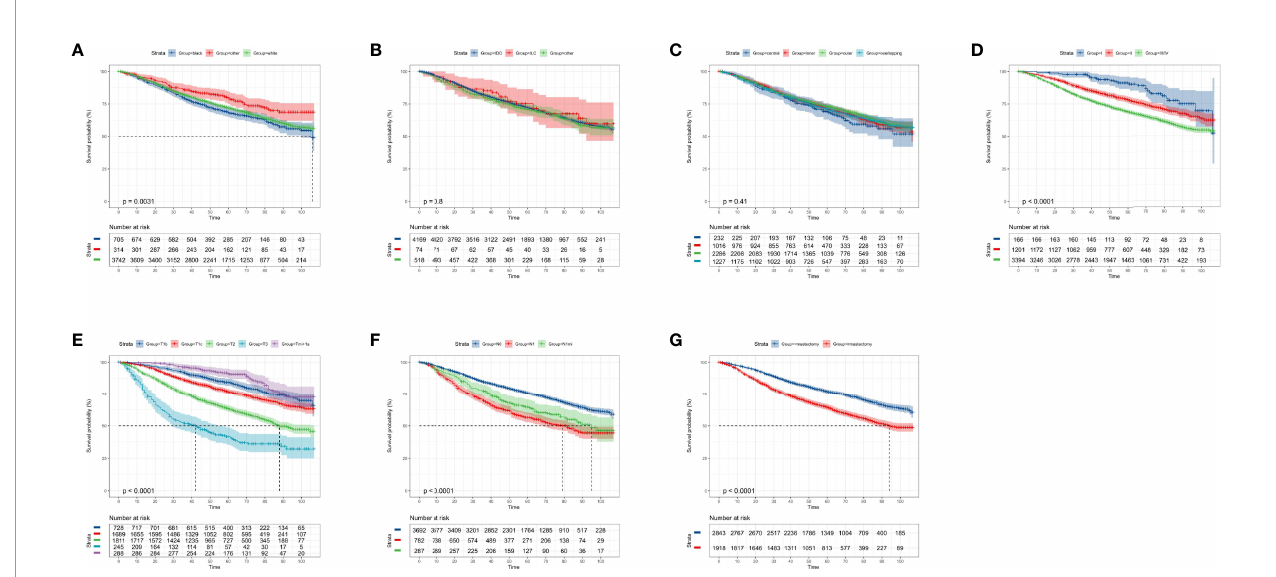
FIGURE 4 | Kaplan – Meier overall survival analysis of 4,761 women aged 70 years or older with primary operable, triple-negative breast cancer regarding the clinicopathological characteristics. (A) Race. (B) Histology. (C) Tumor location. (D) Differentiation grade. (E) T stage. (F) N stage. (G) Surgical extension. other: de fi ned as the Asian/Paci fi c Islander and American Indian/Alaska Native; Grade: I: well-differentiated, II: moderately differentiated, III/IV: poorly differentiated and undifferentiated; central: central portion of breast combined with nipple; other: other types of breast cancer. TNBC, triple-negative breast cancer; IDC, invasive ductal carcinoma; ILC, invasive lobular carcinoma. Tick marks indicate censored data.